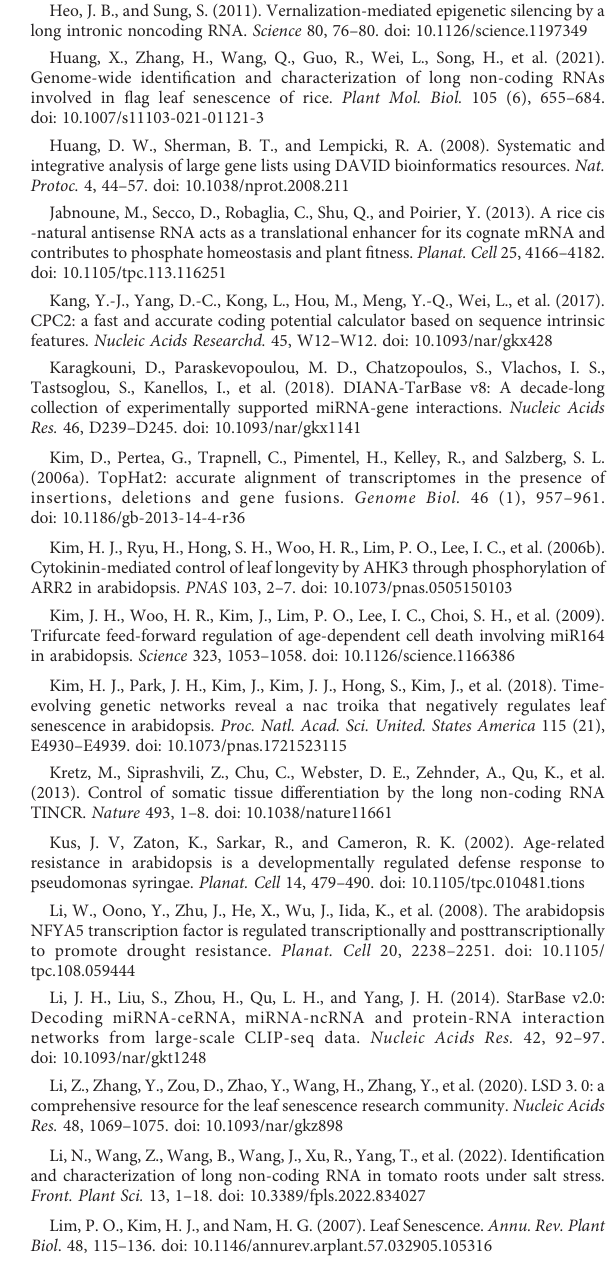
at2g14878 leaves during developmental (A) and dark-induced leaf senescence (B) by qRT-PCR. In (A) and (B) , data the mean of two replicates, and error bars represent SD ( n = 2). Statistical analysis was performed using student ’ s t-test (*, p < 0.05; **, p < 0.01; ***,